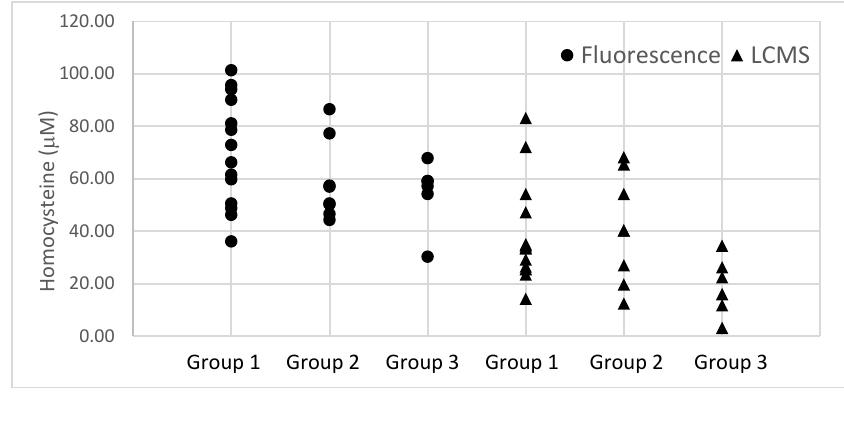
Figure 1. Homocysteine level measured by the fluorescence and LC-MS methods in PD patient sera (Group 1—PD patients not treated with levodopa; Group 2—PD patients treated with levodopa; Group 3—Healthy